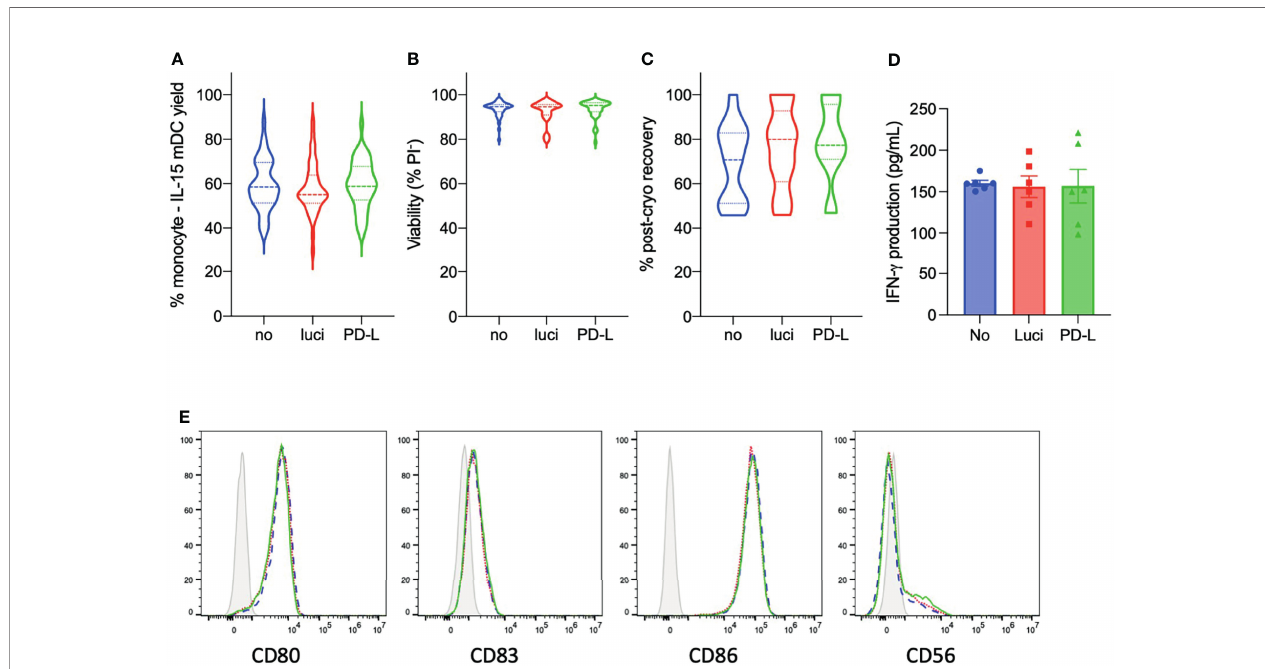
FIGURE 2 | Phenotypic characterization of PD-L silenced mature IL15 DCs. Violin plots of (A) monocyte-to-mature IL-15 DC yields (n = 44), (B) viability (% PI - ; n = 44) and (C) post-cryopreservation (post-cryo) recovery 15 to 30 min after thawing (n = 13) from untreated (no), control siRNA-treated (luci) and PD-L1/PD-L2 siRNA-treated (PD-L) IL-15 DCs at harvest. (D) Concentration of IFN- g , an IL-15 DC hallmark, in 24-hour cell-free supernatants of IL-15 DC monocultures (100,000 cells; n = 6). (E) Representative histogram overlays of key surface markers of mature IL-15 DCs on no siRNA IL-15 DCs (blue dashed line) and PD-L siRNA IL-15 DCs (line histogram), including the corresponding isotype control (grey fi lled line). IFN- g , interferon gamma; mDC, mature dendritic cells.